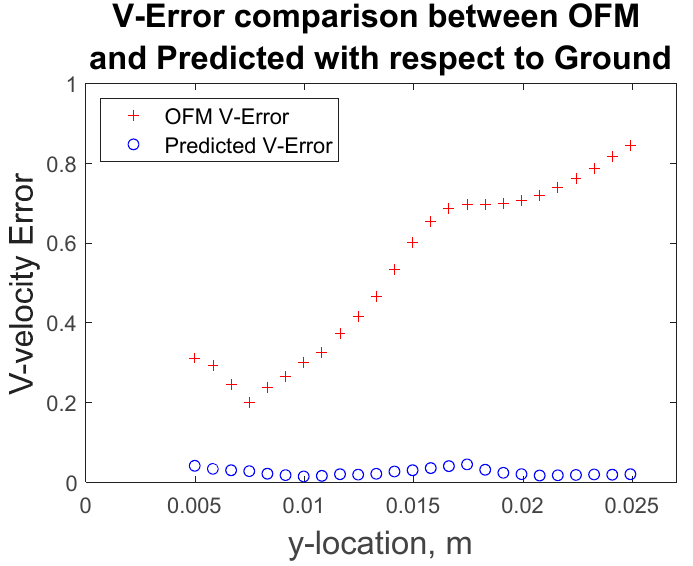
Figure 10. Percentage error of OFM estimation and MLP predicted results for v-component velocity with respect to the ground truth data at various Y-locations.